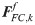
Stochastic model of filopodia penetration dynamics in 3-D ECM fiber network.A) Schematic representation of three focal complexes (FCs) (‘a’) moving along ECM fibers in different directions. Free body diagram of the k-th filopodial node and the j-th node in the i-th fiber in the circle marked in A), where three and two external forces are acting, respectively. Note that, the sum of FFC,kf and FFC,f,ije is zero. B) a magnified view in A), showing the structure of FC including an integrin node at the filopodial membrane to an underlying ECM fiber, illustrating a stochastic ligand-receptor bonding process at the FC site. Note that, A) and B) represent top and side views, respectively.